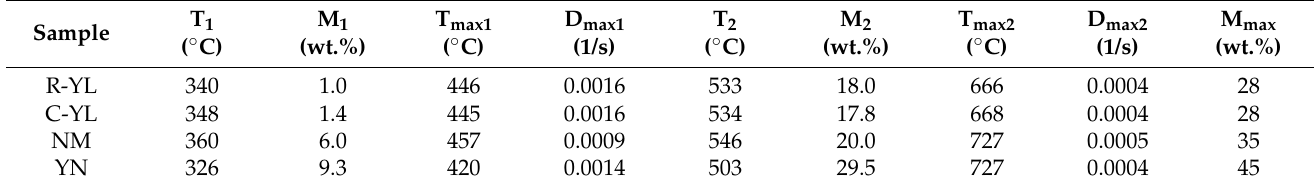
Figure 5. Pyrolysis of NM and YN in TGA, 10 K/min, 1 bar, ( a ) NM, ( b ) YN. Table 3. Pyrolysis of four low-rank coal in TGA, 10 K/min, 1